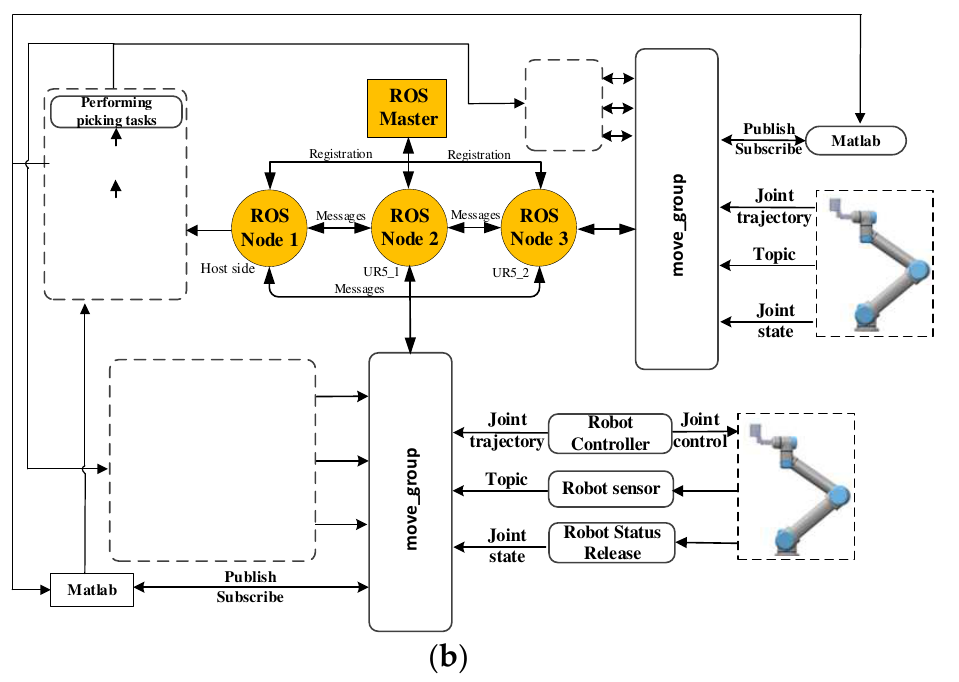
Figure 2. Overview of the double-arm harvesting robot. ( a ) Double-arm harvesting platform. ( b ) The robot operating system based on software architecture of the double-arm robot.